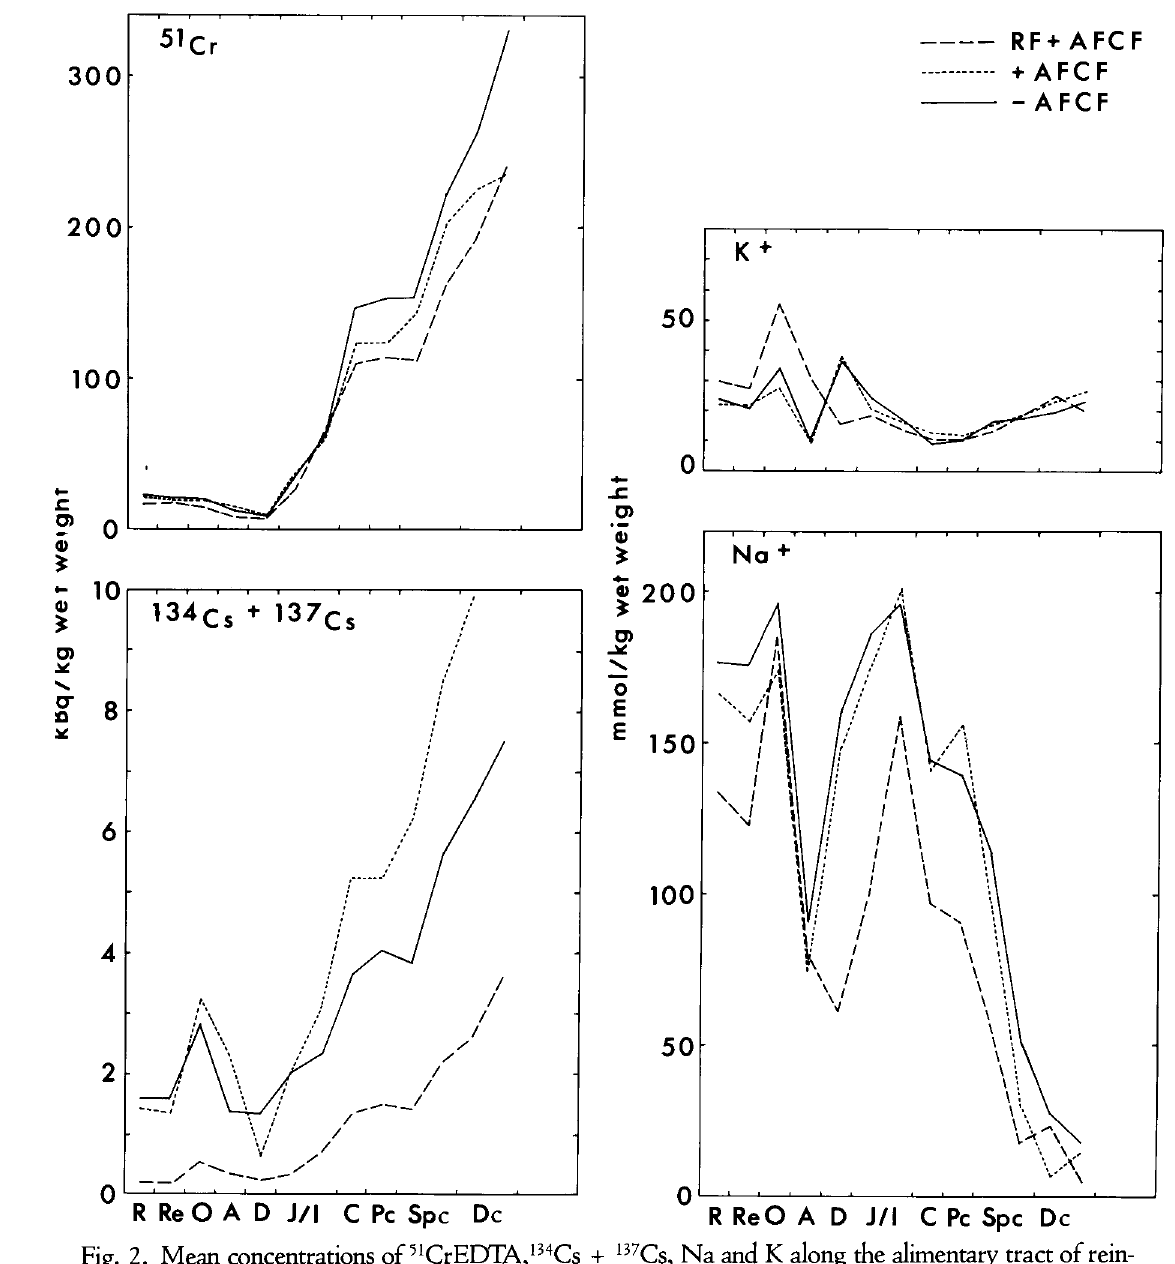
R Re O A D J/| C Pc Spc Dc R ReO A D J/l C Pc Spc Dc 2. Mean concentrations of 51 CrEDTA, 134 Cs + 137 Cs, Na and K along the alimentary tract of rein Fig. deer fed different diets and with or without treatment with (AFCF). Abbreviations are given in Fig.